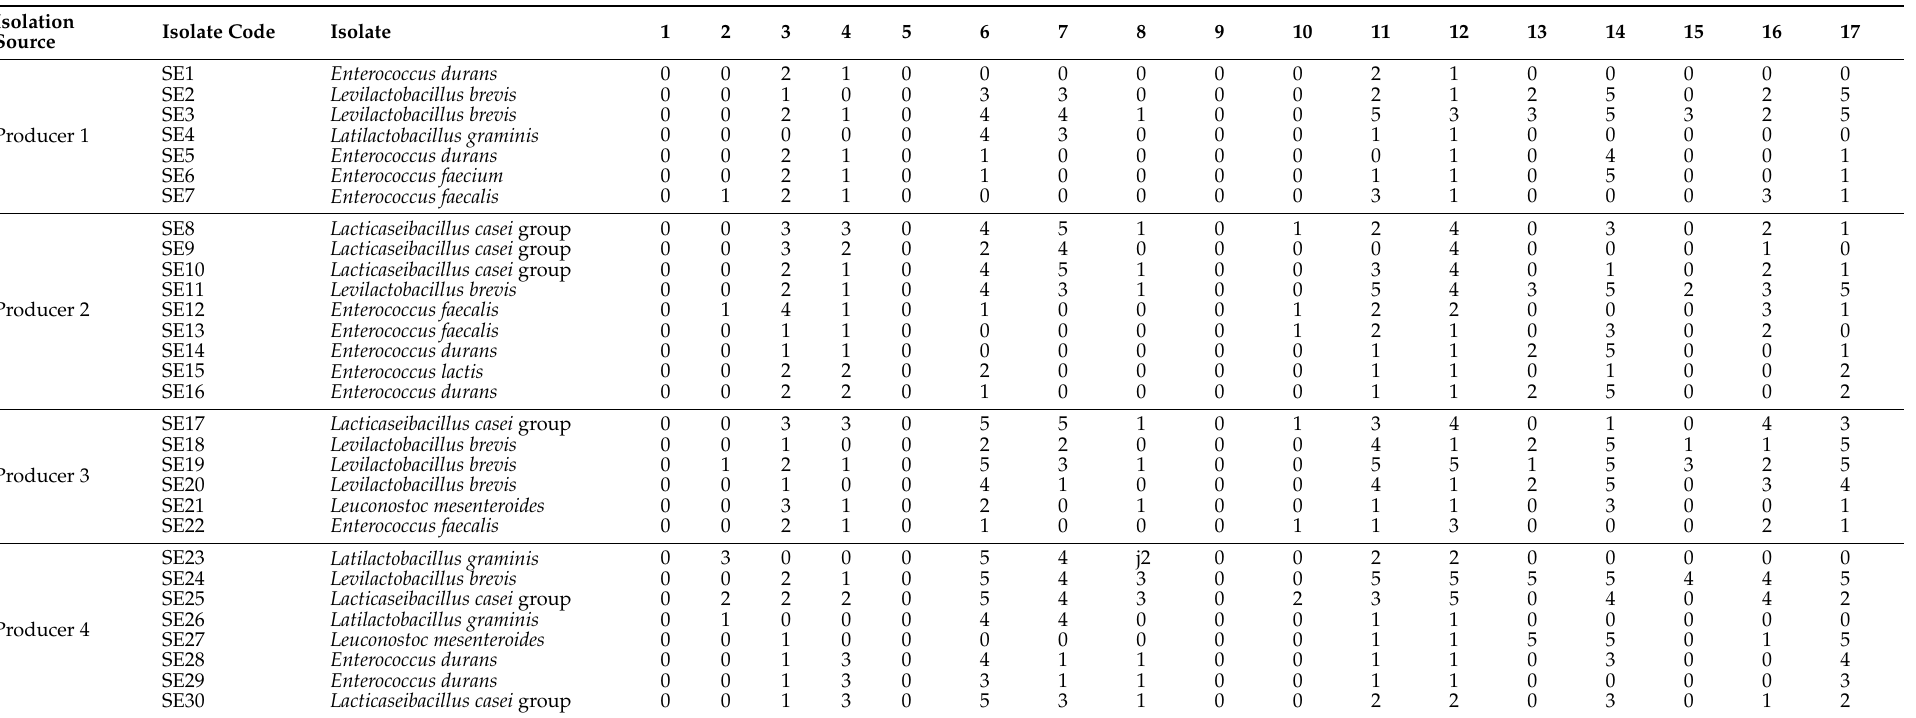
Table 6. Semi-quantitative assessment of enzymatic activity of the pool of collected isolates from Queijo Serra da Estrela PDO